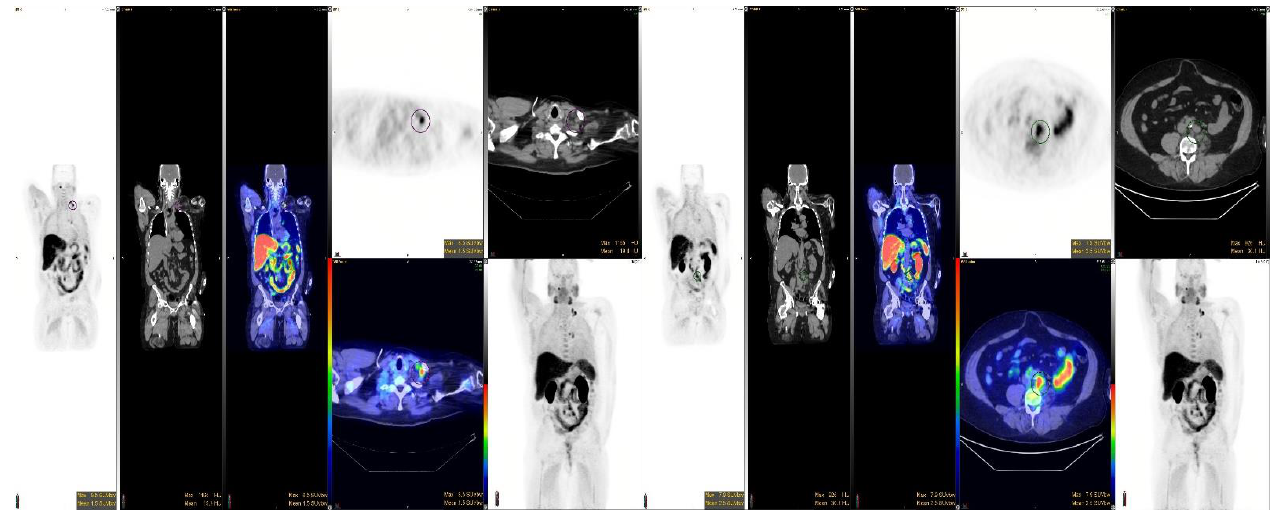
Figure 1. Choline PET/CT shows the extra-prostatic extension of PCa with involvement of left su- praclavicular and retroperitoneal lymph nodes.